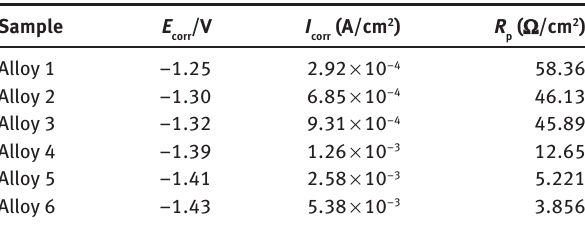
Table 4: Electrochemical data of the composites with different FAC contents in 3 wt.% KCl at 25 °